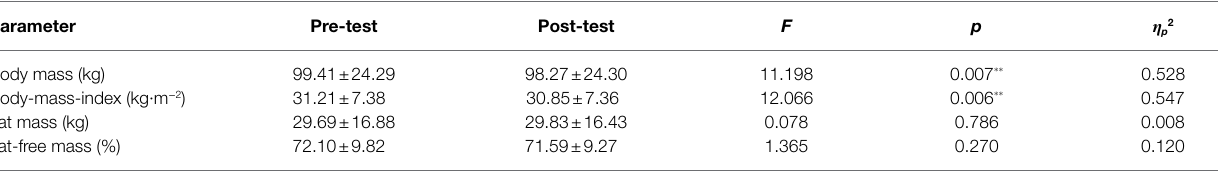
TABLE 2 | Anthropometric parameters (means ± SD) before and after the intervention ( n = 11). Parameter Pre-test